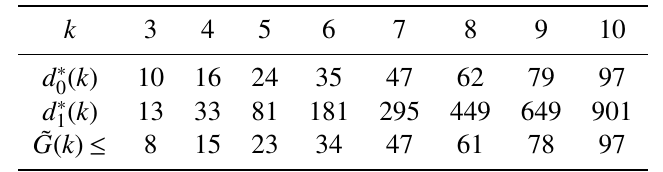
Table 1: Comparison between the values of d ∗ [6], and the known upper bounds on ˜ G ( k ) in Bourgain [3] and Vaughan